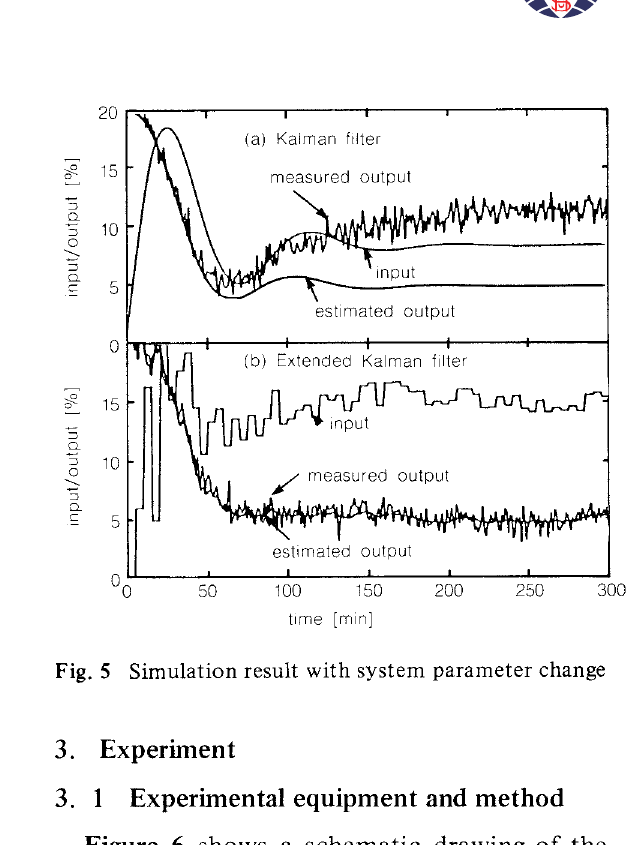
Fig. 5 Simulation result with system parameter